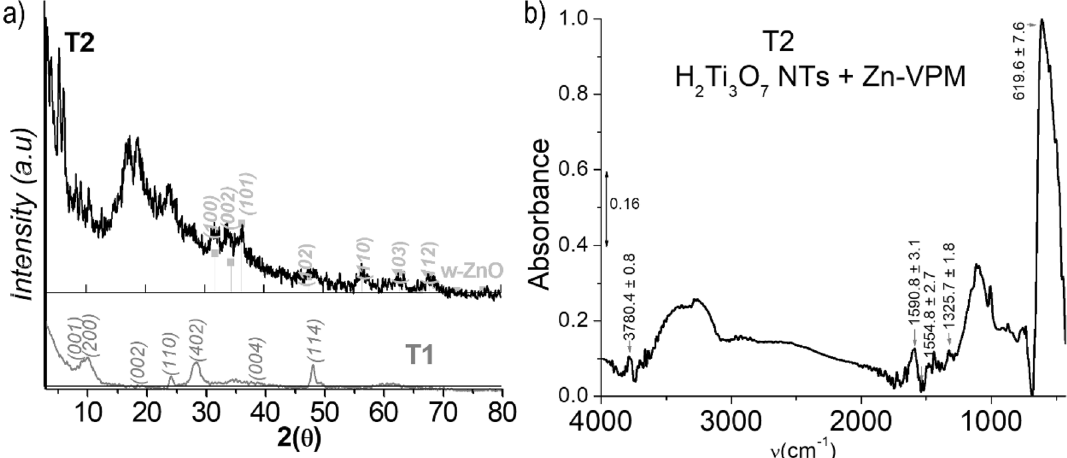
Figure 6. X-ray diffraction of T2 ( a ) contrasted with T1 and ZnO (ICDD card 361451). The XRD analysis of the sample provided knowledge of the chemical nature of the Zn incorporated by VPM and the peculiarities of the laminar wall morphology of the nanotubes. Normalized IR spectrum of T2 in the range of 450–4000 cm −1 ( b